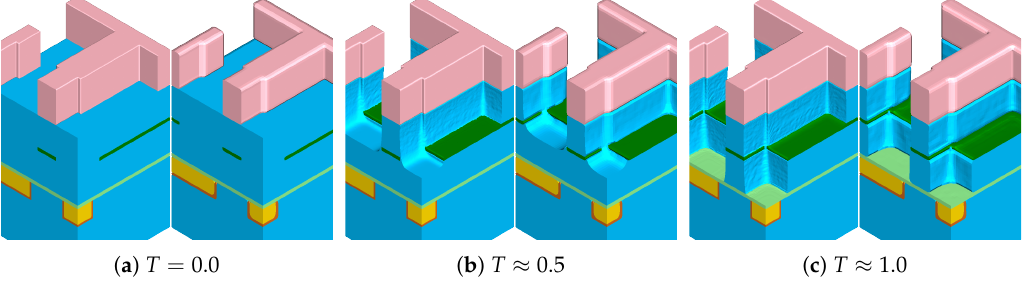
Figure 7. Resulting material regions of the multi-material etching simulation of the dielectric layer for resolution 128 (left half of each figure) and 32 (right half) at different times T